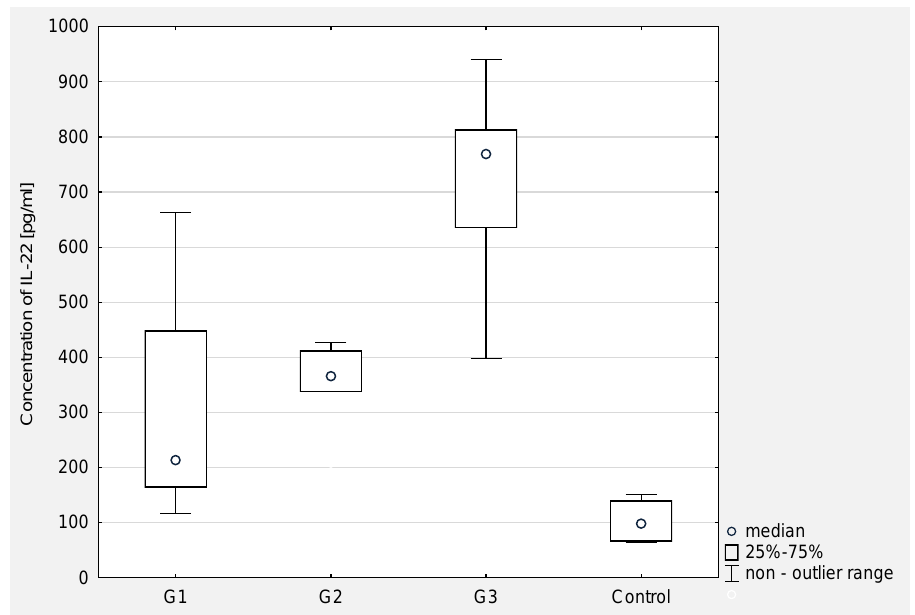
Figure 5. The concentration of IL-22 in the serum of women with ovarian cancer depending on the degree of differentiation G1 (well differentiated), G2 (moderately differentiated), G3 (poorly differentiated) compared to the control group.